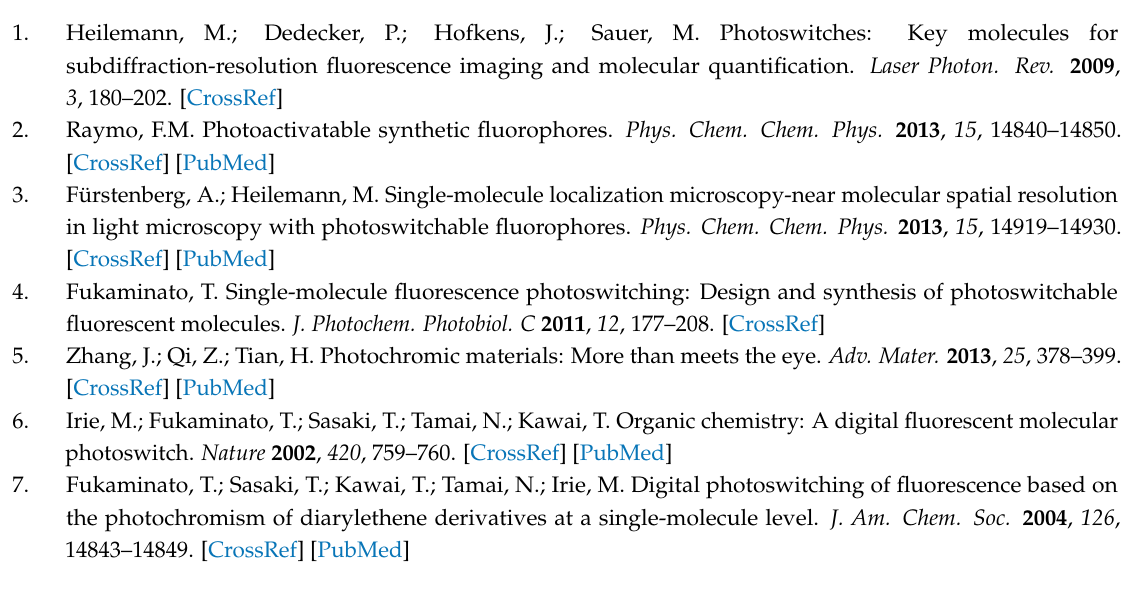
Table S1: Fluorescence quantum yields of 1b – 5b in various solvents, Scheme S1: Syntheses of compounds 2a – 5a